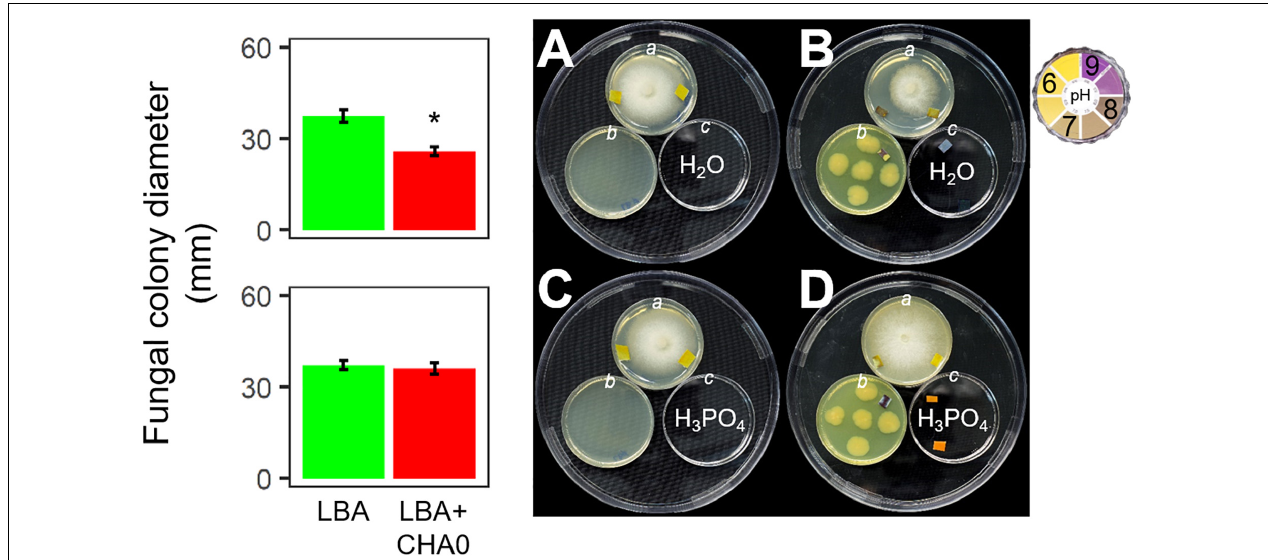
FIGURE 4 | Experiment E. Involvement of ammonia in the growth inhibition of Heterobasidion abietinum strain 10 (plates in the top angle of the triangles) mediated by Pseudomonas protegens CHA0 (plates in the bottom left angles of the triangles). The 55 mm-plates labeled with a contained PDA and were inoculated with H. abietinum strain 10. The plates b contained LBA and were inoculated with CHA0 (150 mm-plates, B,D ) or uninoculated (A,C) . The plates c contained water (A,B) or phosphoric acid (C,D) . The three 55 mm-plates were incubated without lid inside the 150 mm-plates which were sealed with Parafilm R (cid:13) M to avoid the escape of volatiles emitted by CHA0. Pieces of litmus paper were placed on the agar surface at the photo capturing time to check its